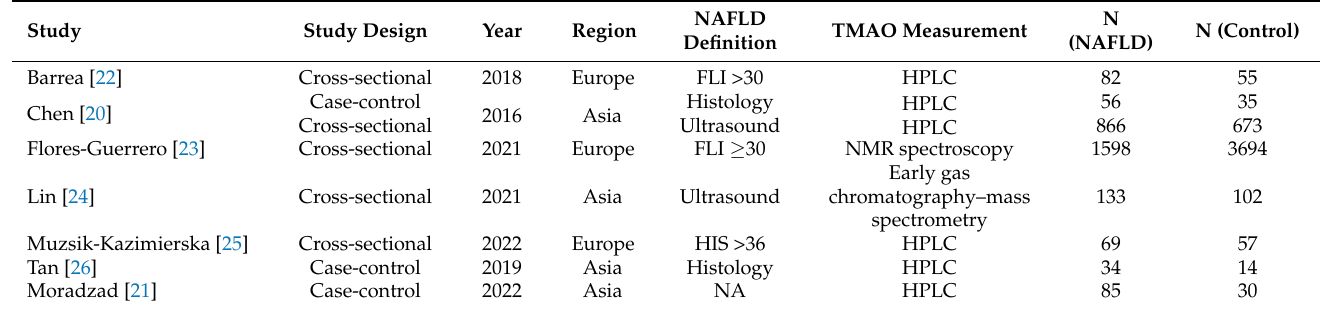
Table 1. Characteristics of the studies included in the meta-analysis.